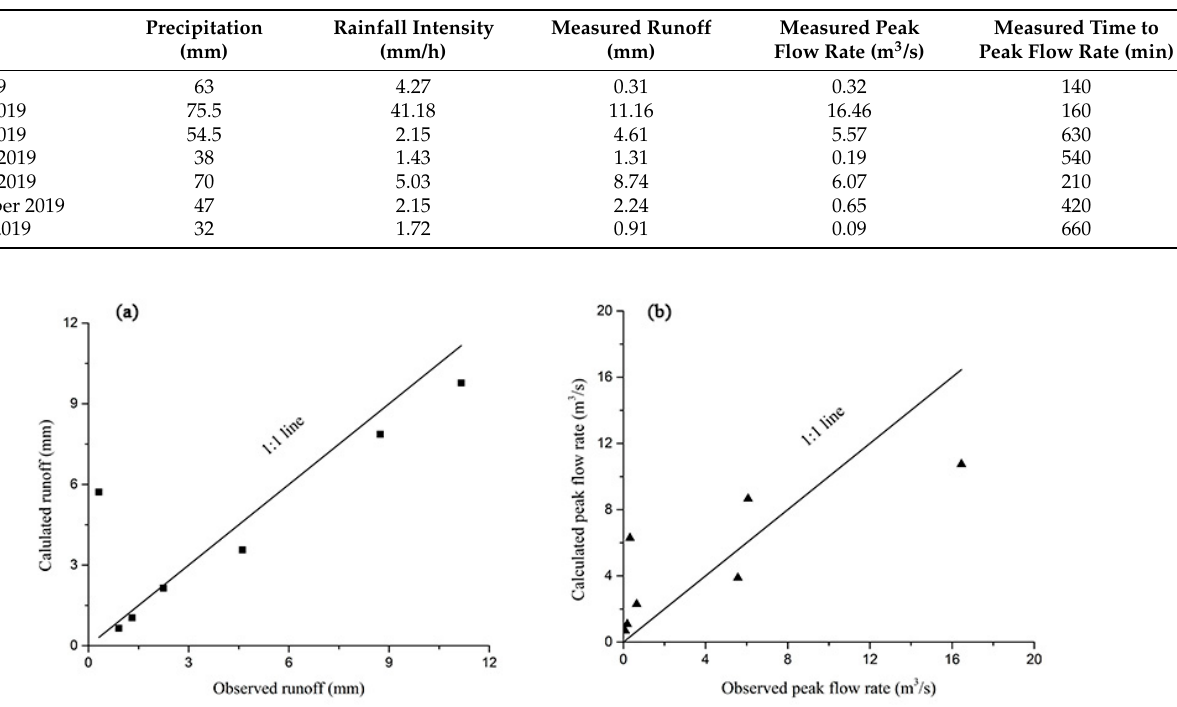
Figure 7. Scatter diagrams between observed and validated runoff (a) and peak flow rate (b). 3.2. Simulated Surface Runoff The calibrated CN values were used to calculate surface runoff. The paired T-test showed that the estimated event surface runoff before and after GLC was different at a significance level of 0.05 (Table 3). Table 3. Effects of the GLC on hydrological variables based on paired T-tests. Variable